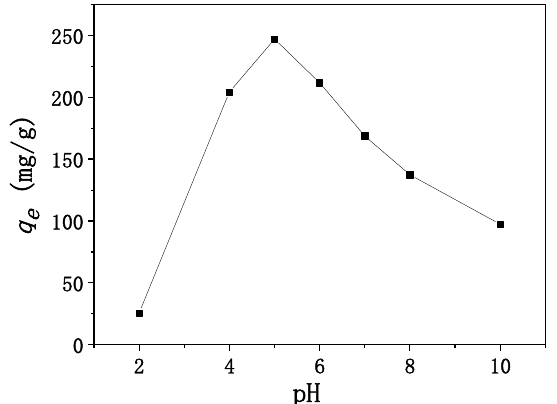
Figure 5. Variation curve of uranium (VI) adsorption capacity of NiCo 2 O 4 /MWCNTs with pH. tem- perature, 25 °C; C 0 , 150 mg L − 1 ; pH, 2.0–10.0; the mass of NiCo 2 O 4 /MWCNTs, 0.01 g.